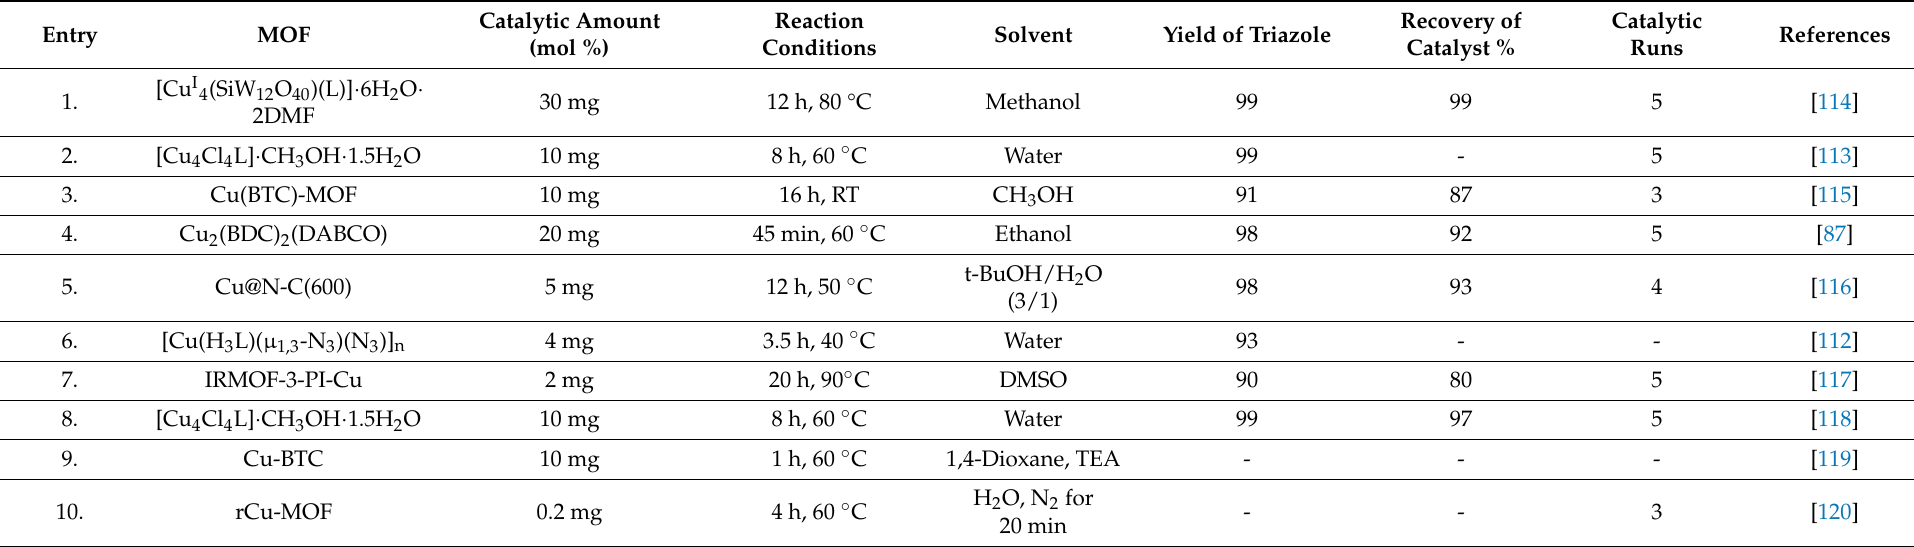
Table 6. Copper-based MOFs for the synthesis of 1,2,3-triazole via the CuAAC